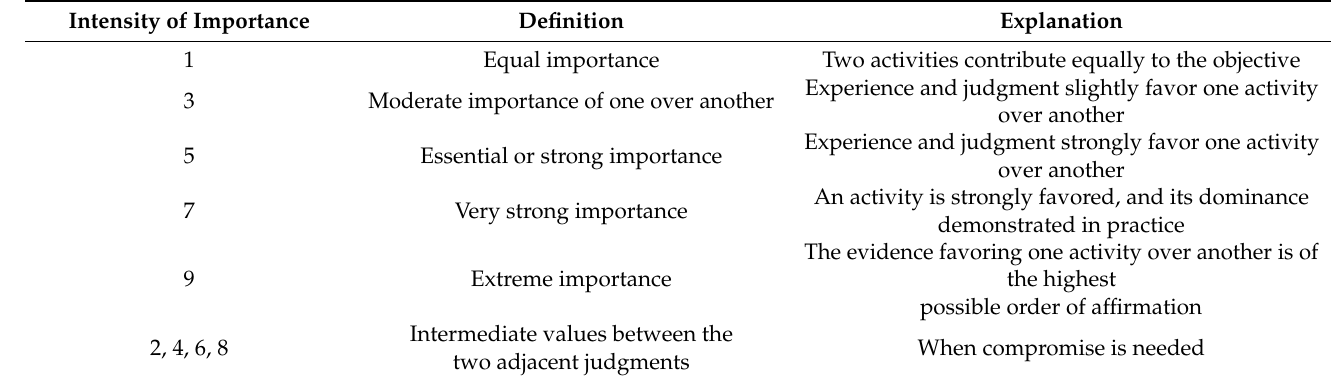
Table 3. The fundamental scale of numbers is used in the AHP